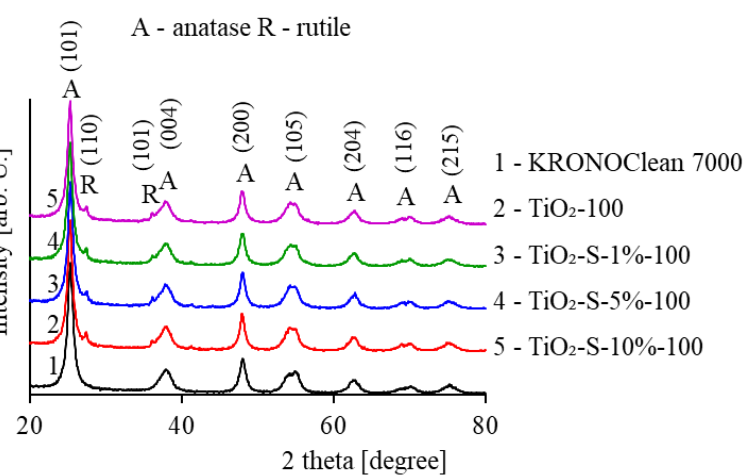
Figure 2. XRD patterns of the reference KRONOClean 7000, starting TiO 2 -100 and carbon-modified photocatalysts.